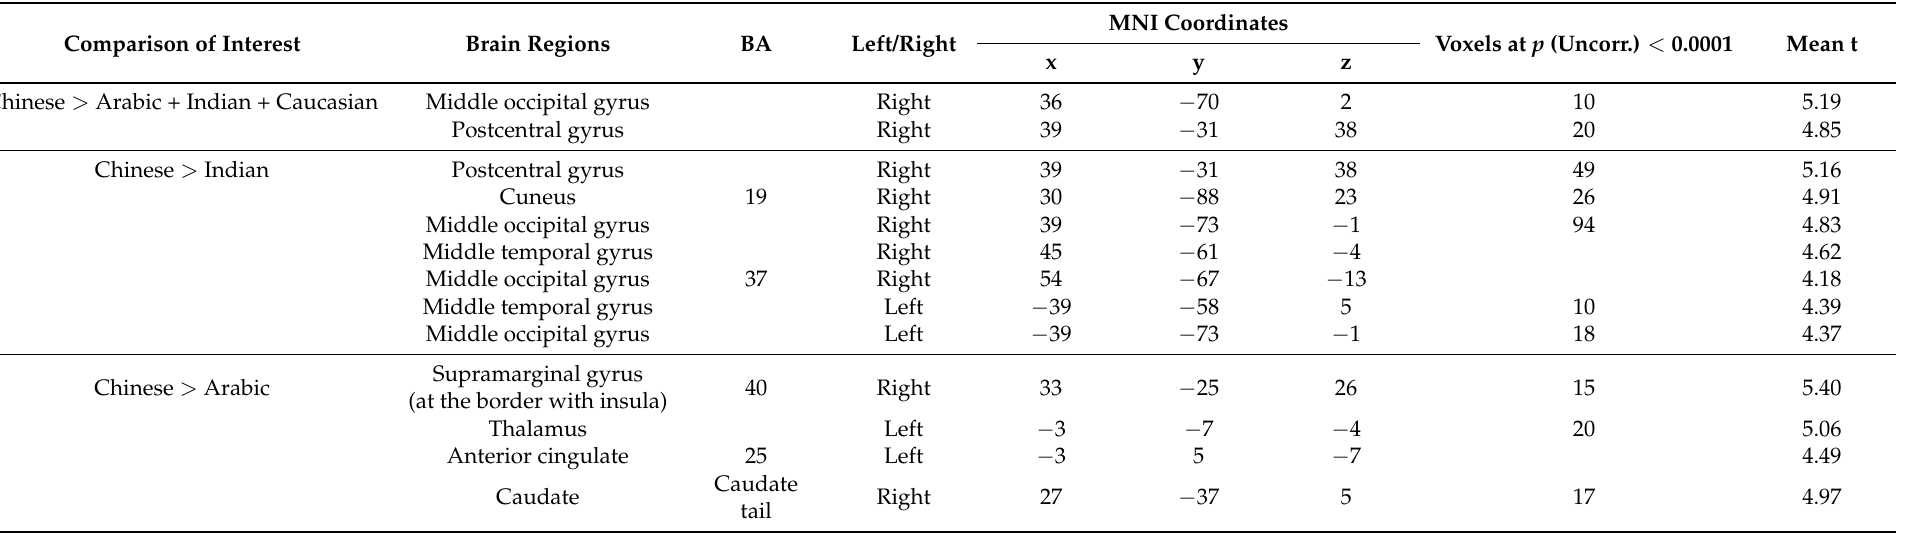
Table 1. Regions of significant neural activation ( p < 0.0001 (uncorrected)) for the following contrasts: Chinese vs. Arabic + Indian + Caucasian faces , Chinese vs. Indian faces , and Chinese vs. Arabic faces . No significant result emerged for the contrast Chinese vs. Caucasian faces